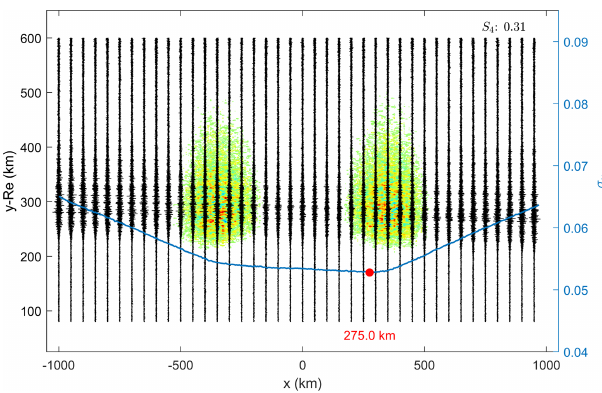
Figure 11. Bubbles at x ref , 1 = − 346 . 7 and x ref , 2 = 346 . 7km; σ (cid:49)ρ/ρ = 17%. Estimation error ε x 2 = 71 . 7km.